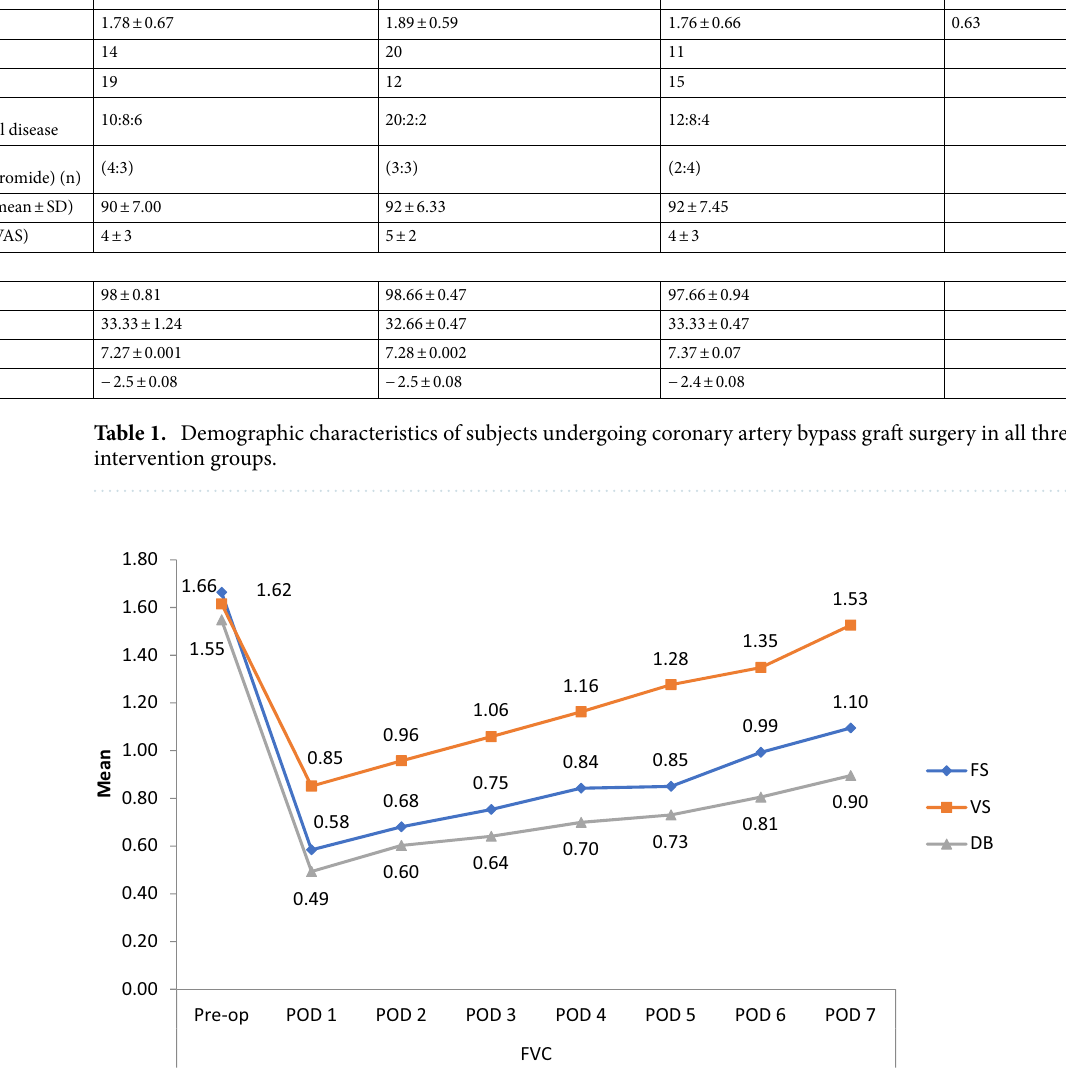
Figure 3. Comparison of forced vital capacity (FVC) before and after coronary artery bypass graft surgery between three